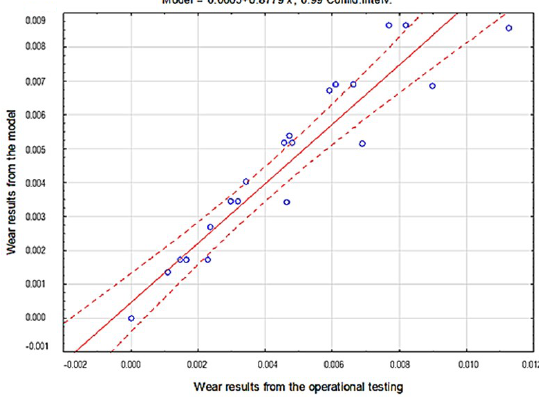
Figure 17. The course of the correlation of theoretical data with empirical data for steel in heavy soil.